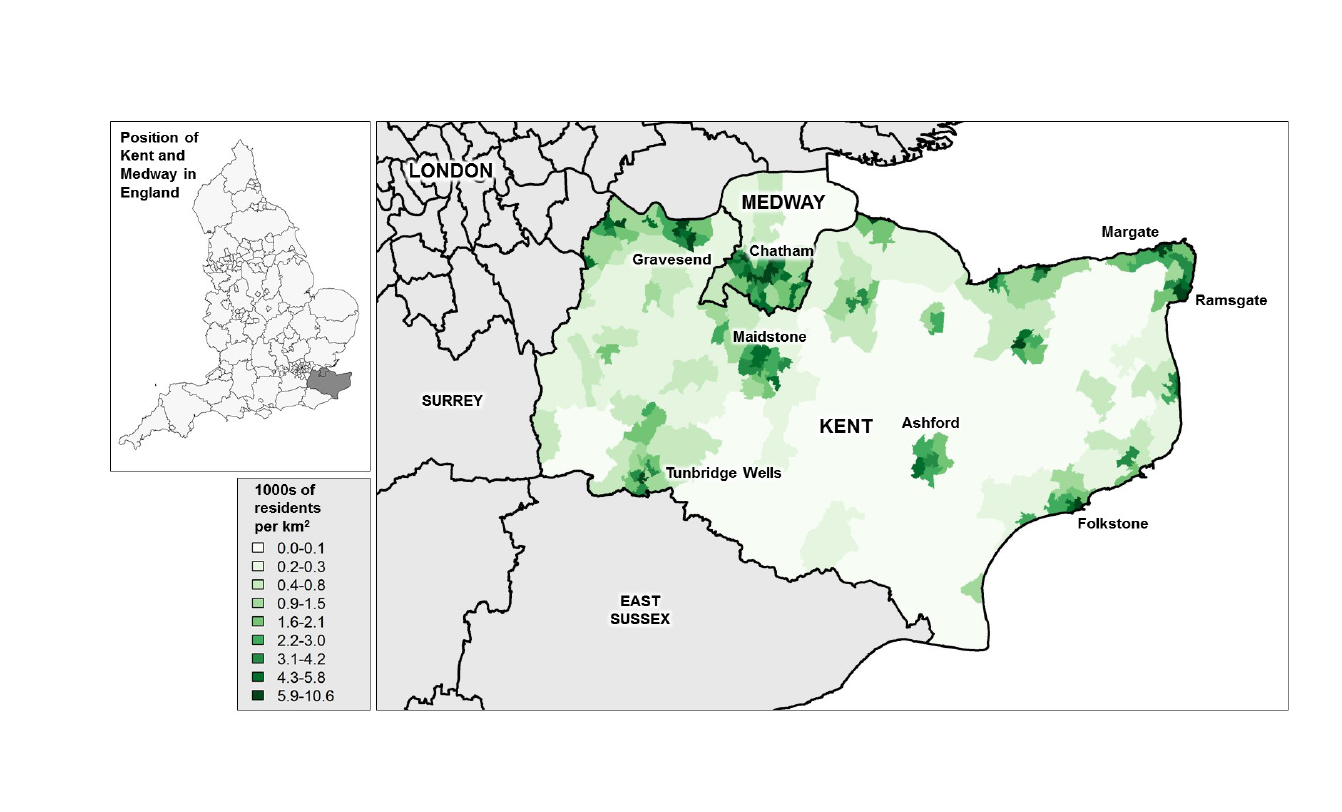
Figure 1: Geographical location and population density of Kent and Medway